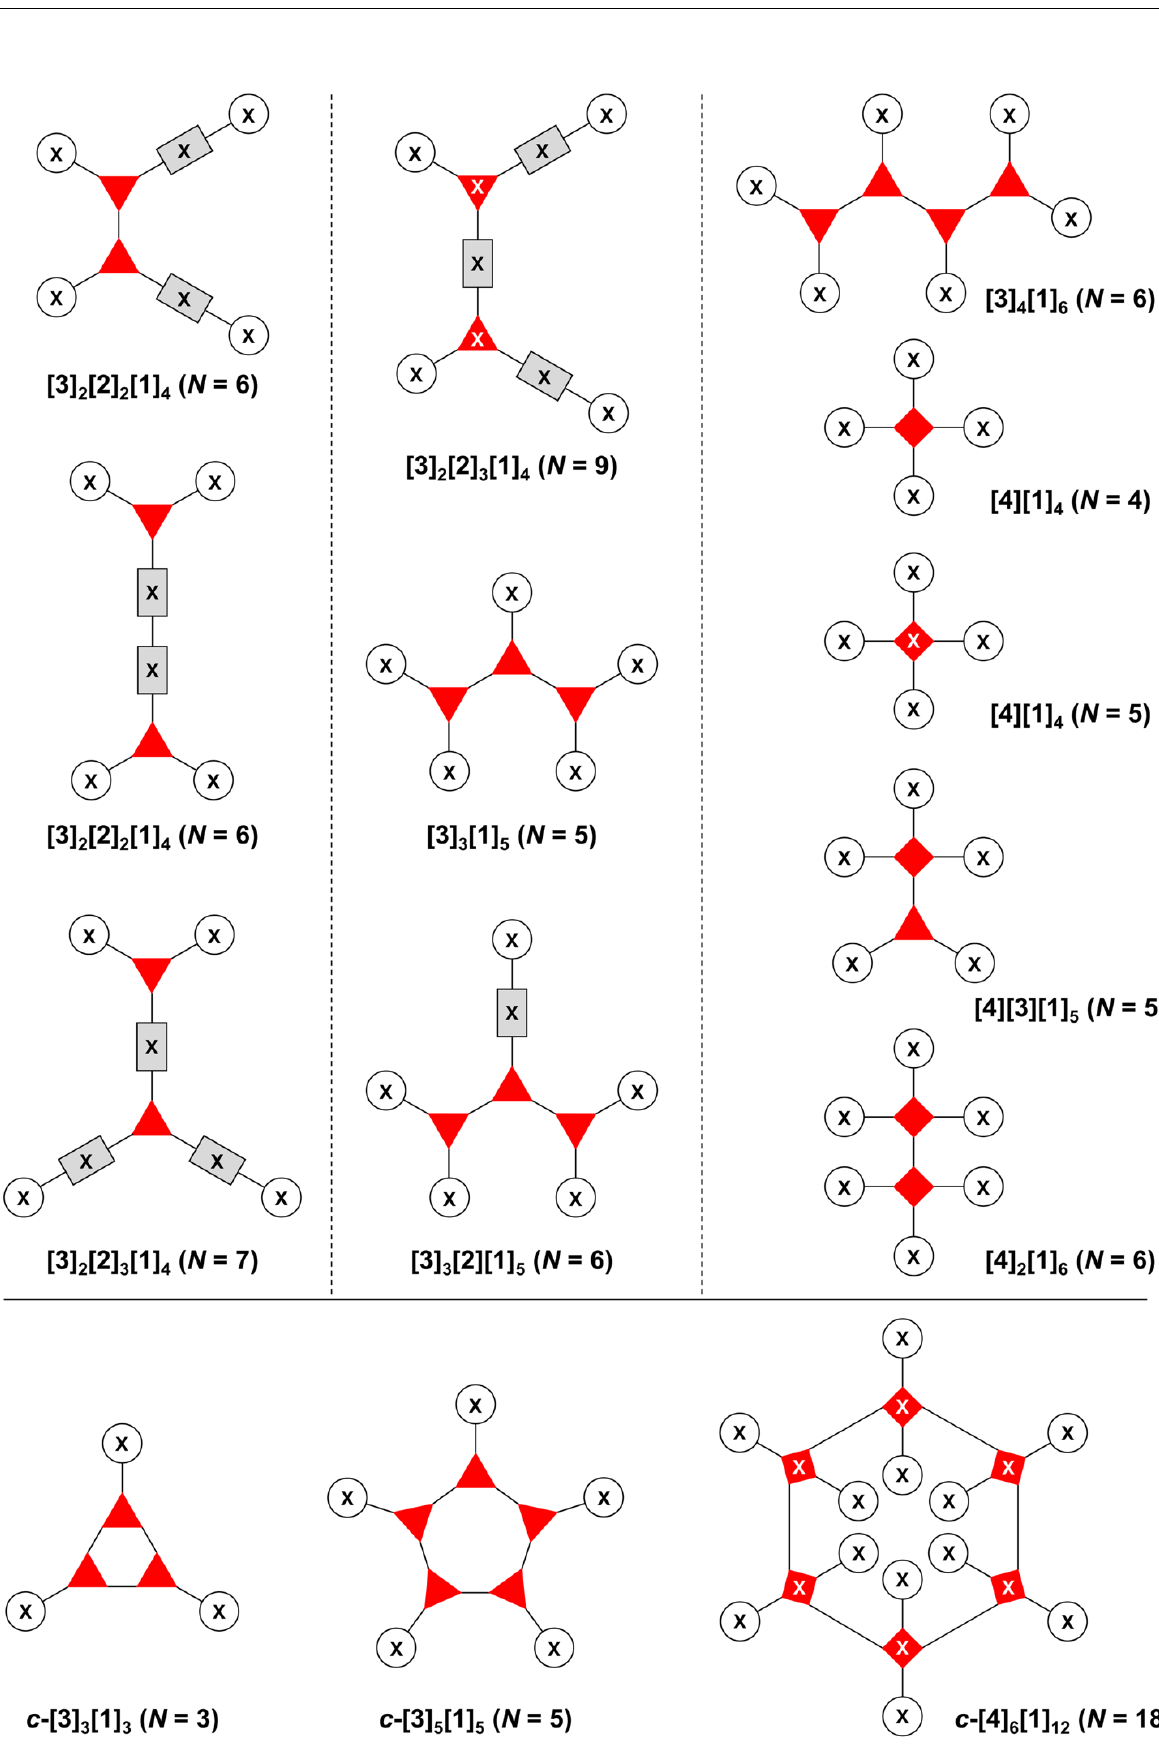
Figure 4. All graphs treated